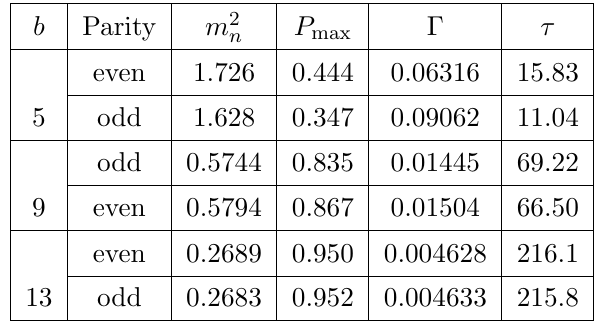
Table 4. The mass spectrum m 2 , relative probability P max , FWHM (cid:0) and life-time (cid:28) of a part of n the resonances quasi-localized on sub-branes with di(cid:11)erent brane thickness b for the double brane model (3.8).